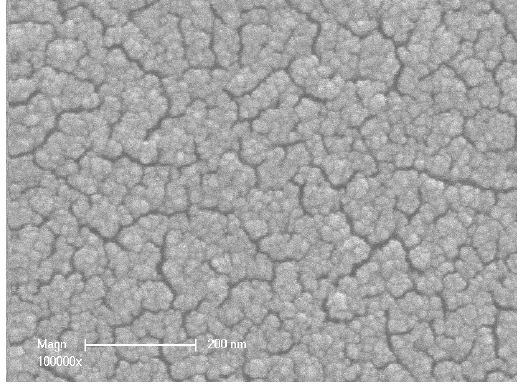
Figure 2. SEM photograph of the membrane surface (top view of the active layer 100,000). The electric surface charge of the membrane was investigated by zetametry measurements [30].